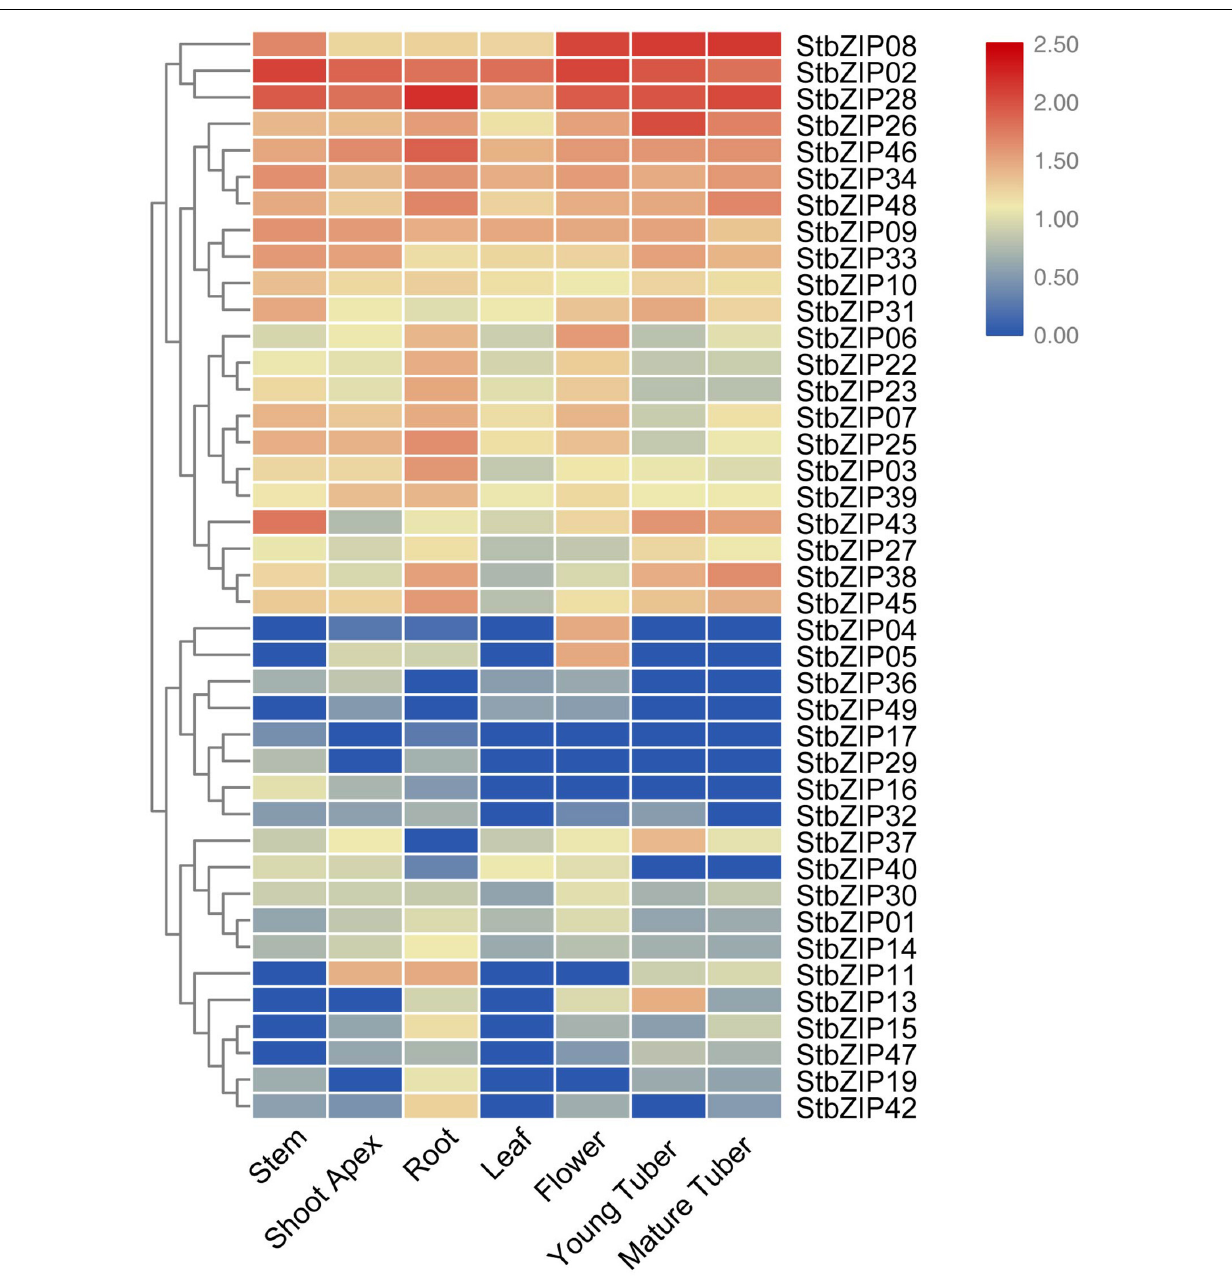
white ( Figure 9B ), indicating that StbZIP25 functioned as a transcriptional